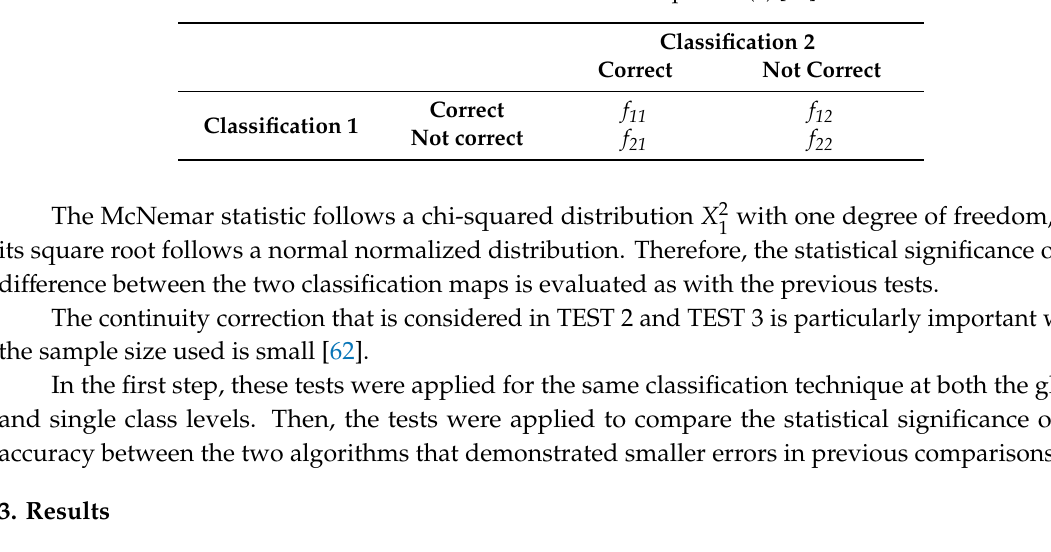
Table 1. The matrix elements used in Equation (3)